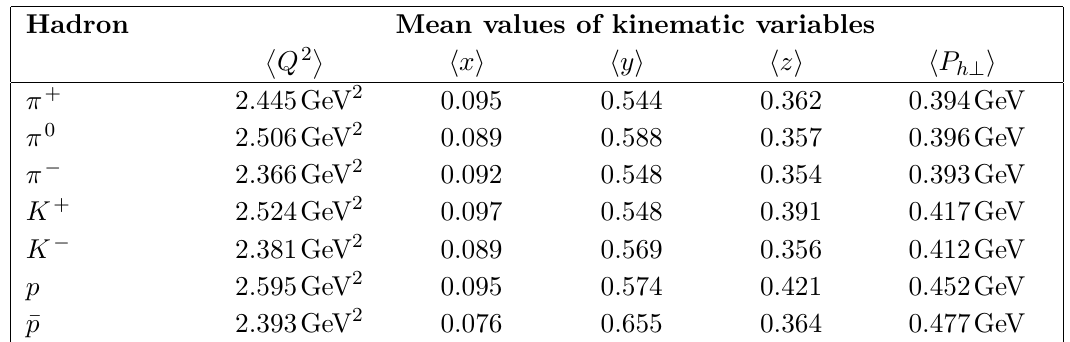
Table 10 . Mean kinematic values for pions, charged kaons, as well as for protons and antiprotons in the standard semi-inclusive range 0 . 2 < z < 0 . 7